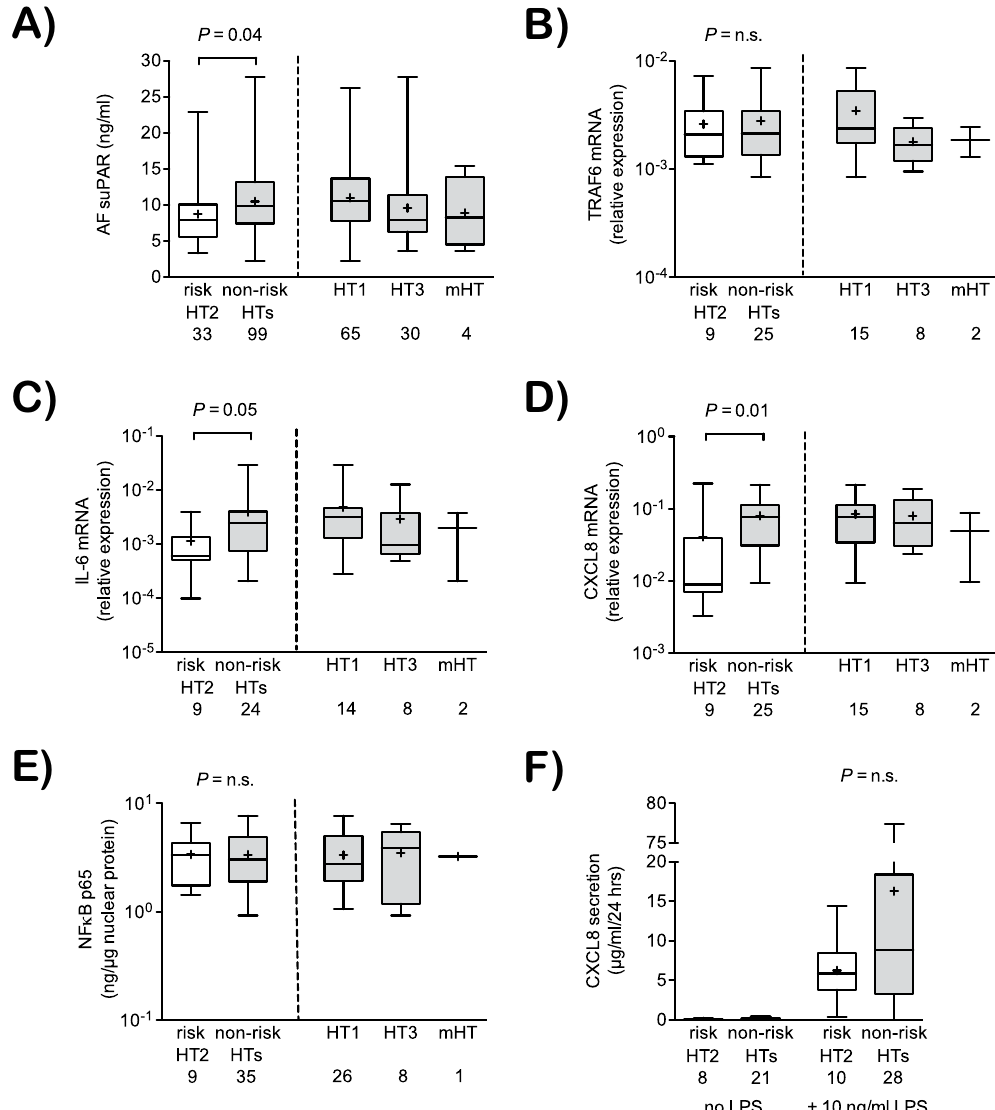
Figure 3. Association of TRAF6 haplotypes with peritoneal immune activation. ( A ) Concentrations of soluble urokinase-type plasminogen activator receptor (suPAR) in non-infected ascites are shown for the different TRAF6 haplotypes. ( B – D ) mRNA expression of TRAF6 , IL-6 and CXCL8 in freshly isolated peritoneal macrophages are shown for the respective TRAF6 haplotypes and were expressed relative to the housekeeping gene ß-actin. ( E ) Nuclear concentrations of active NF- κ B p65 in freshly isolated peritoneal macrophages are shown for the respective haplotypes. ( F ) Quantification of CXCL8 in supernatants from cultivated primary peritoneal macrophages, which were left unstimulated or were stimulated with LPS (10 ng/ml) for 24 hours. All data are expressed as boxplots (min to max). Non-risk haplotypes (HTs) including HT1, HT3 and the mixed haplotype are indicated (right panels) and were pooled and compared to the risk haplotype HT2 (left panels). Numbers of analyzed samples are indicated. P values indicate differences between HT2 and non-risk HTs in Mann-Whitney U test. n.s.: not